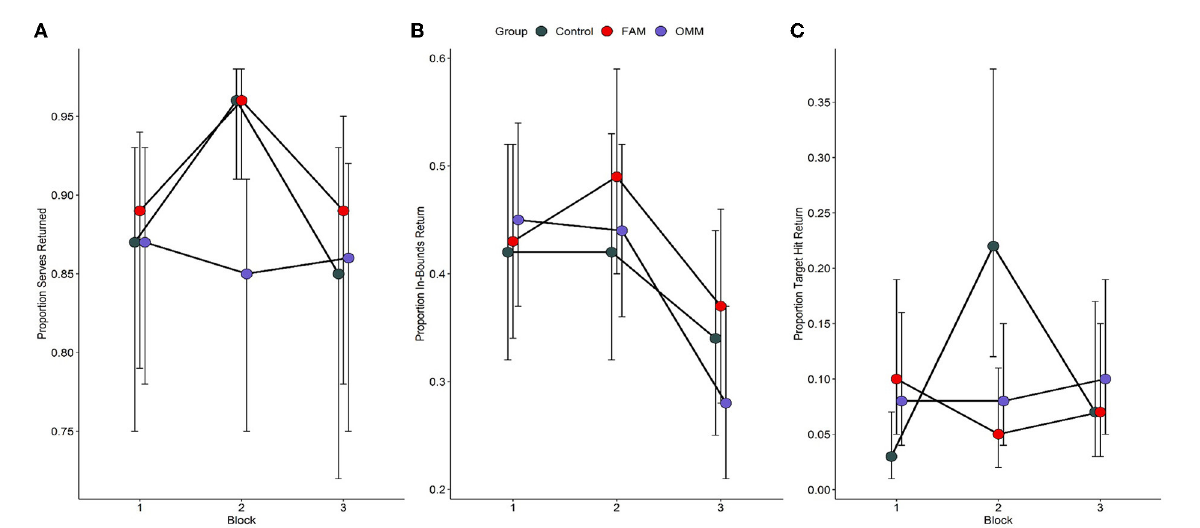
FIGURE4 Proportion of returned serves (A) , returned serves placed in-bounds (B) , and target hits (C) as a function of mindfulness meditation or control groups and sequenced tennis task blocks. A significant group by block interaction was observed for the proportion of returned serves ( p < 0.05) based on a significant increase in returned serve proportion between blocks 1 and 2 and then a significant decline in proportions at block 3 for the control group. No significant changes across blocks were observed for FAM and OMM groups. There was no significant group by block interaction for the proportion of in-bounds returns ( p = 0.28). A significant group by block interaction was observed for the proportion of returned serves placed within a target area ( p < 0.001) based on a significantly higher target hit proportion for the control group as compared to the FAM group in block 2. Furthermore, a significant increase in target hit proportion between blocks 1 and 2 and then a significant decline in proportions at block 3 for the control group while no significant changes across blocks were observed for FAM and OMM groups. In blocks 1 and 2 of the sequenced tennis task, four serves were sequenced in a repeating 12-serve second-order conditional sequence unbeknownst to the returner. In block 3, the sequence was altered by introducing two novels serves and presenting the serves in a novel 12-serve second-order conditional sequence. Prior to block 1 of the task, participants completed a brief single session of focused-attention meditation (FAM), open-monitoring meditation (OMM) or a control condition involving listening to an audio book. Error bars represent 95% confidence